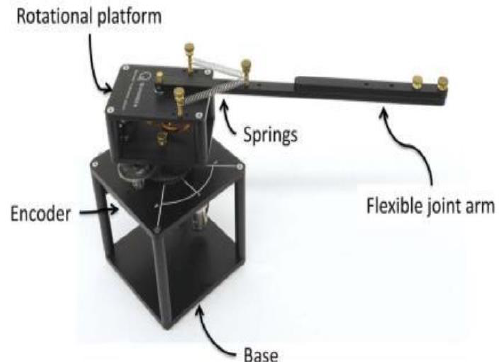
Figure 1 . Flexible joint robot arm by Quanser [41]